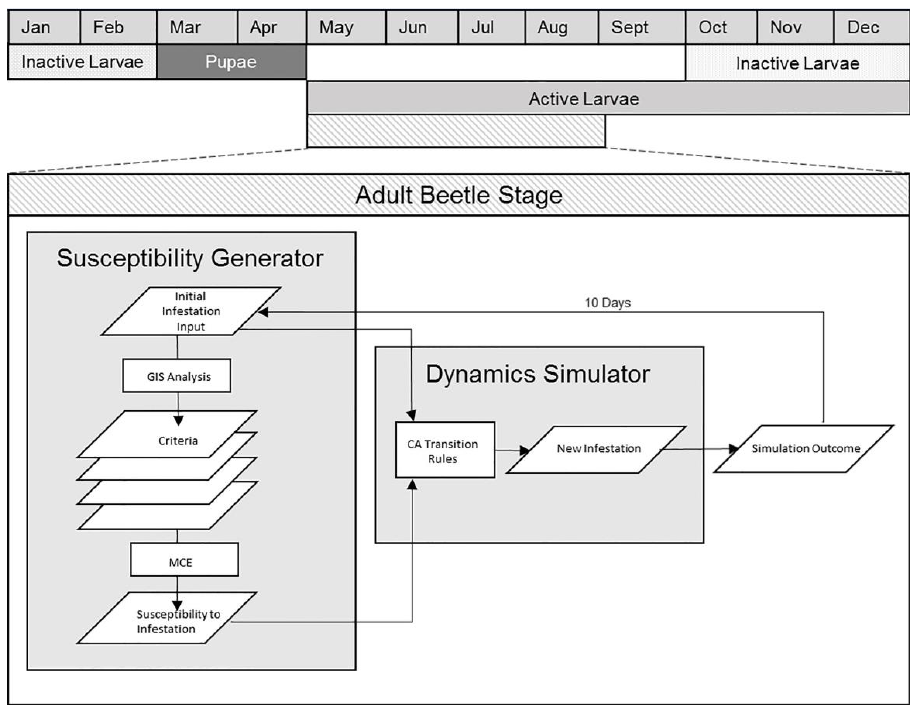
Figure 2. The structure of CA-EAB model that generates EAB propagation during the adult beetle stage in the EAB lifecycle and that consists of two sub-models, a susceptibility generator and a dynamics simulator.